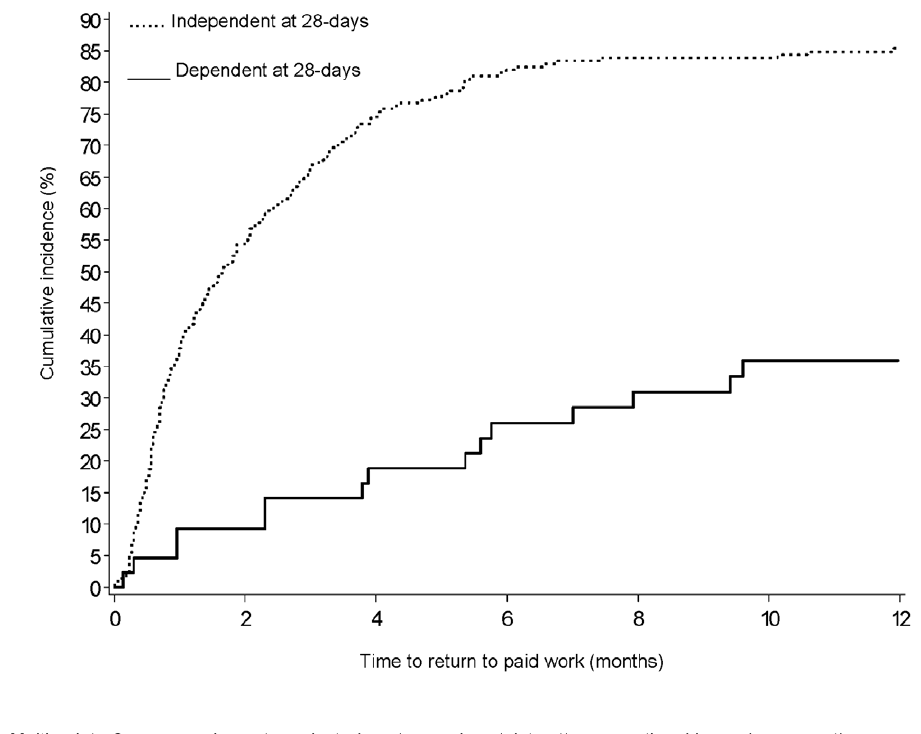
Figure 2. Cumulative incidence (Kaplan Meier plot) in time to return to work over one year by dependence of daily living status at 28 days.